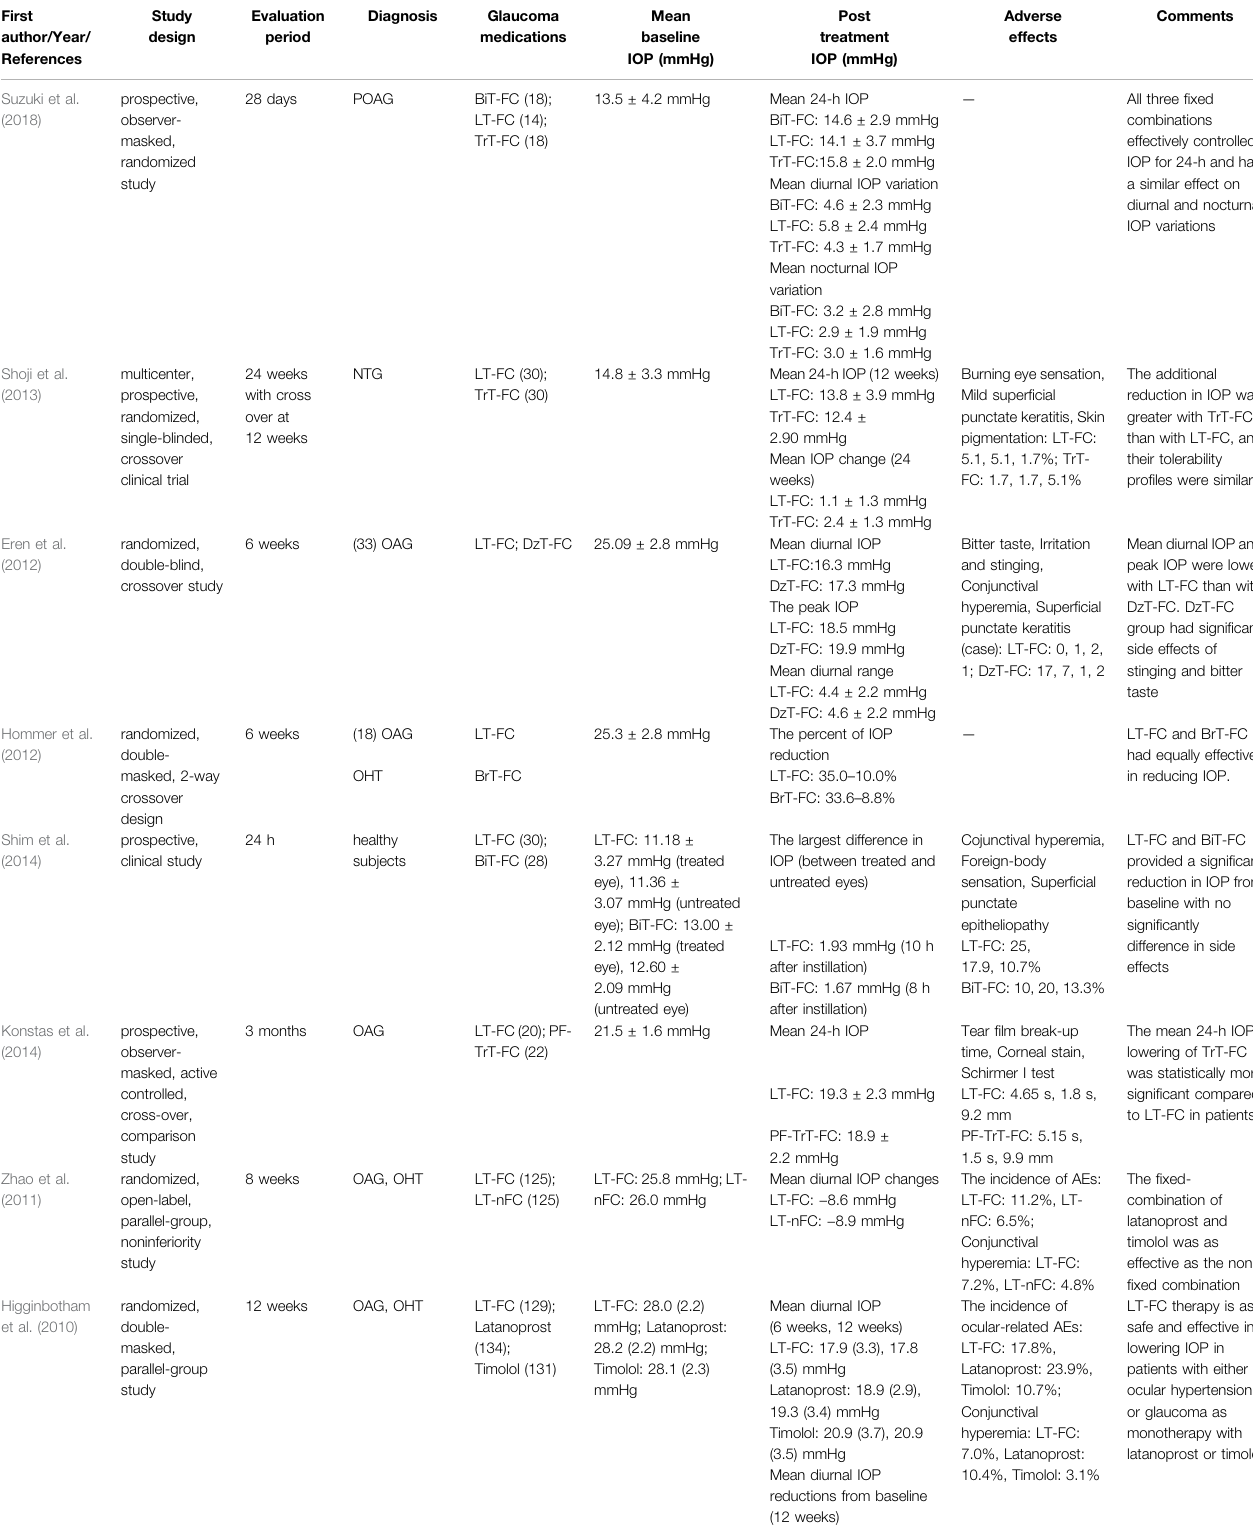
TABLE 6 | A summary of clinical trials comparing different fi xed combination and non- fi xed combination agents. First